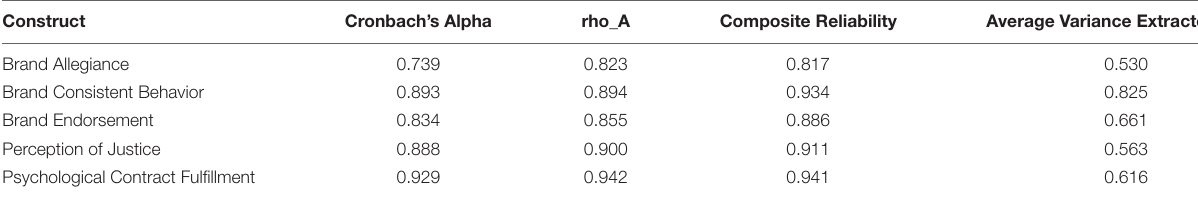
TABLE 2 | Reliability and validity.